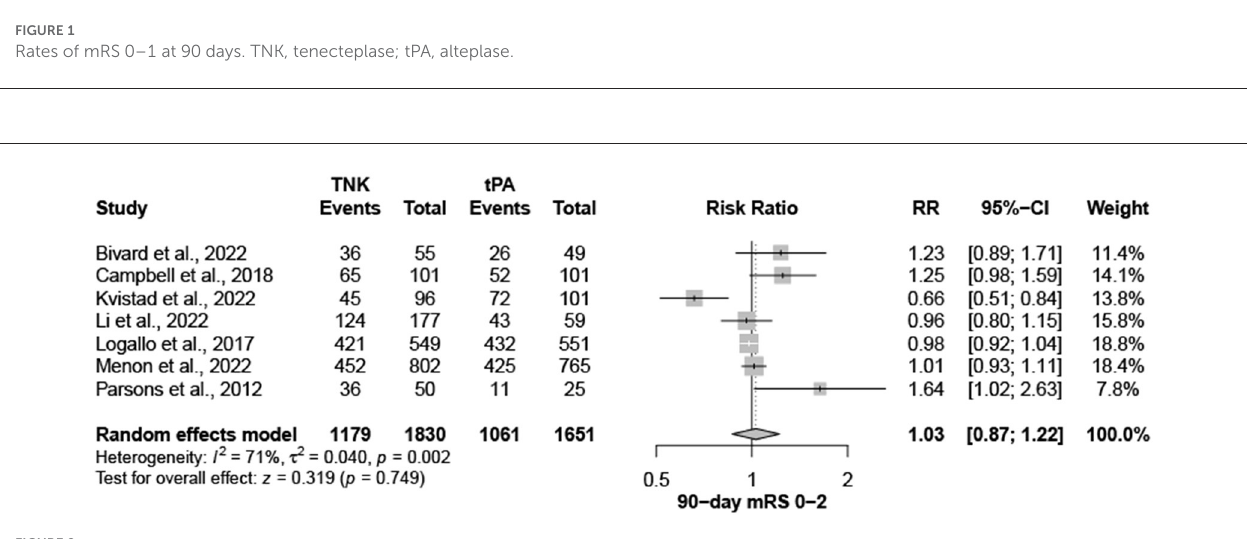
FIGURE2 Rates of mRS 0–2 at 90 days. TNK, tenecteplase; tPA, alteplase.